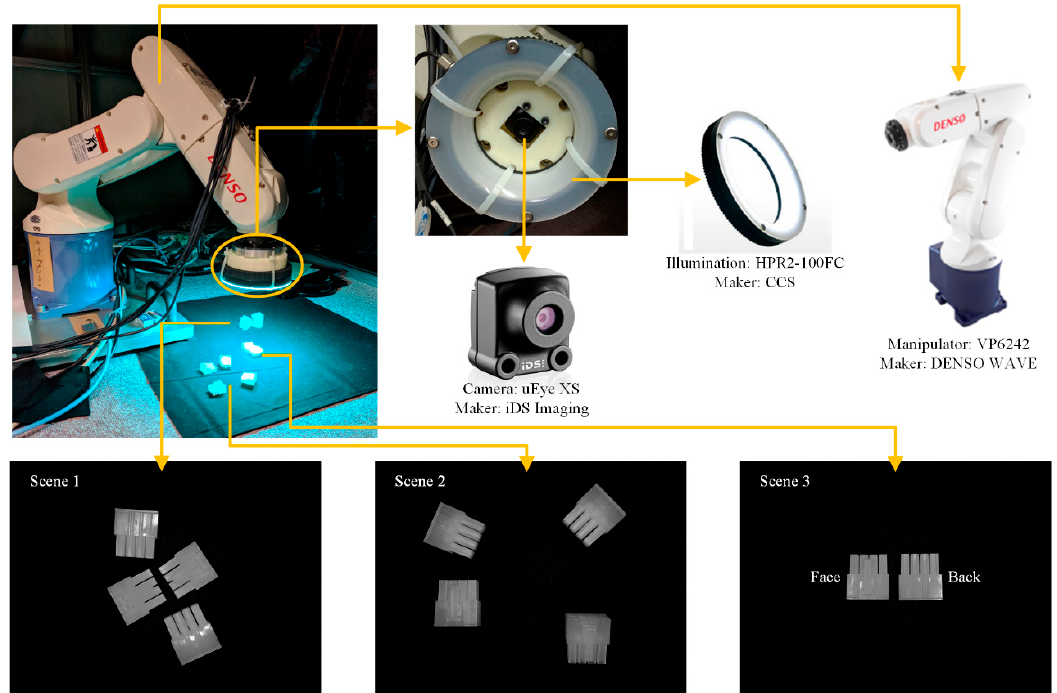
Figure 5. Experimental devices, scenes and recognition targets. Monocular camera and ring-shaped illumination were attached to the end effector of a six-DoF manipulator. Three scenes were prepared on a piece of black cloth; Scene 1 and Scene 2 were for recognition; Scene 3 was for making templates. Two sides of a semi-transparent plastic part (20 mm in length, 20 mm in width, and 8 mm in height) were chosen as the recognition targets.